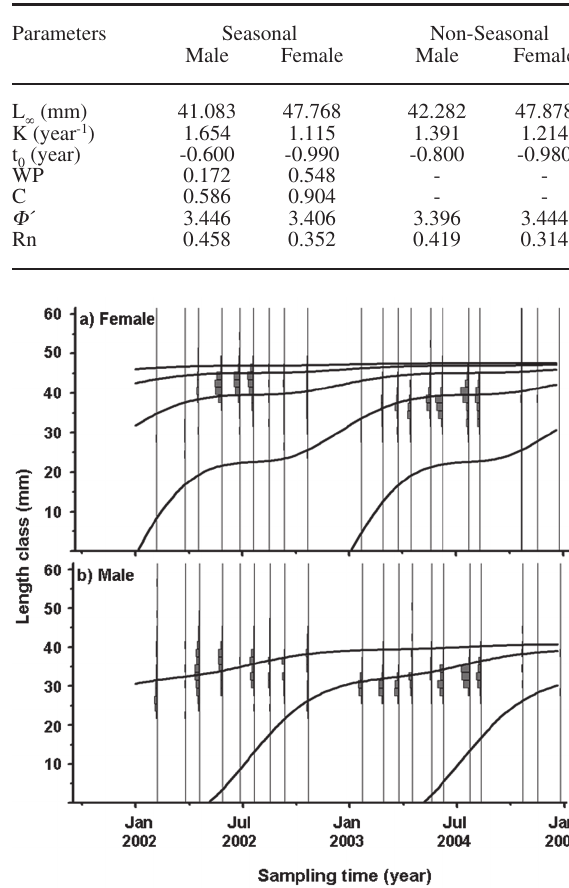
Table 1. – Seasonal and non-seasonal von Bertalanffy growth pa- rameters estimated from the length frequency distribution analysis